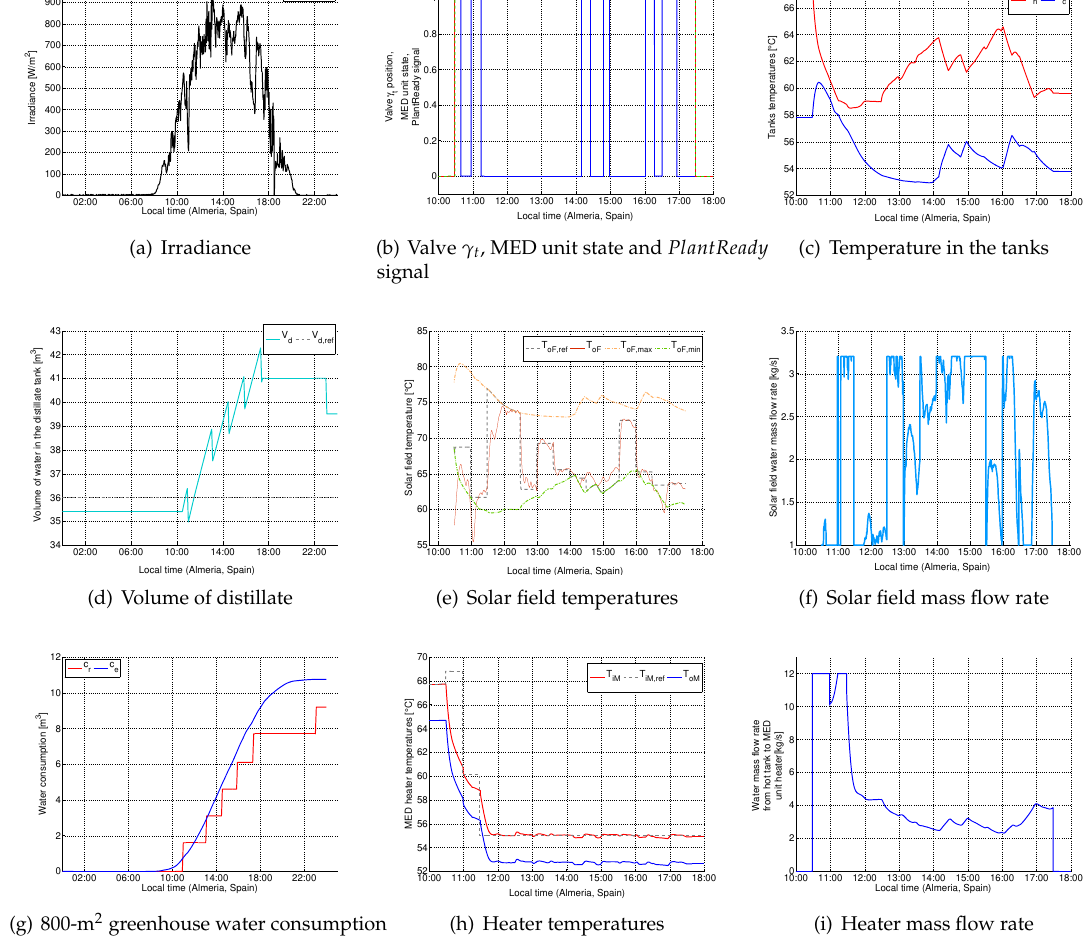
Figure 8. Simulation results obtained for a partly cloudy day. ( a ) Irradiance; ( b ) Valve γ t , MED unit state and PlantReady ; ( c ) Temperature in the tanks; ( d ) Volume of distillate; ( e ) Solar field temperatures; ( f ) Solar field mass flow rate; ( g ) 800-m 2 greenhouse water consumption; ( h ) Heater temperatures; ( i ) Heater mass flow